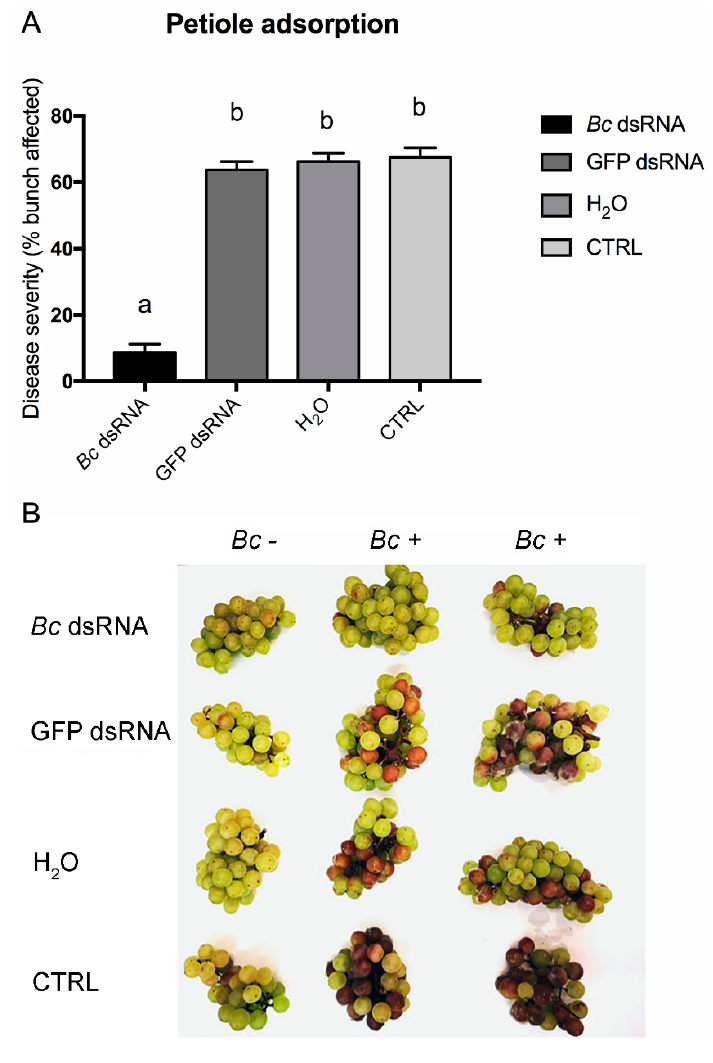
Figure 4. Disease severity on bunches recorded for the in vivo petiole adsorption application method. Percentage of berries affected following Bc dsRNA, GFP dsRNA, H 2 O application and in untreated CTRL samples. Different lowercase letters above bars indicate significant differences as determined by Tukey HSD test ( p ≤ 0.05) ( A ). Overview of representative samples for each condition tested. One bunch was maintained as uninoculated control ( Bc − ) and two inoculated ( Bc +) bunches of cv. Moscato are shown ( B ).